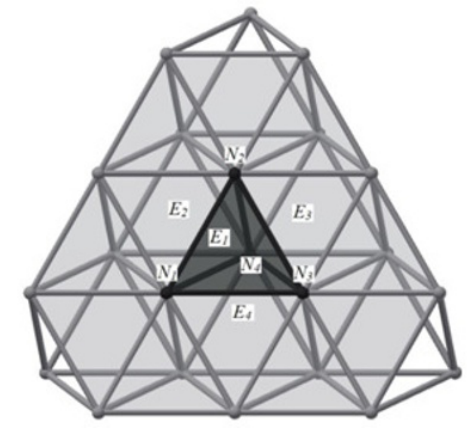
Figure 1. Three dimensional finite element mesh.